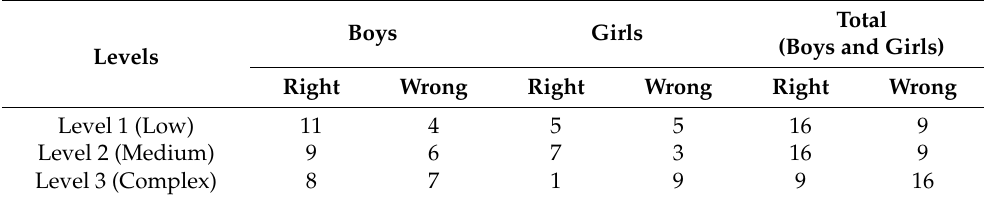
Table 2. Results of the exercises (levels) of the Santa Barbara Solids Test. Total Boys Girls (Boys and Girls) Levels Right Wrong Right Wrong Right Wrong Level 1 (Low) 11 4 5 5 16 9 Level 2 (Medium) 9 6 7 3 16 9 Level 3 (Complex) 8 7 1 9 9